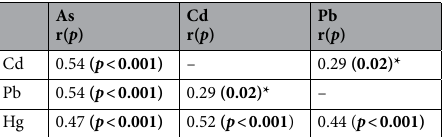
Table 4. Interelement relationships of heavy metals in PCOS cases. *p ≤ 0.05